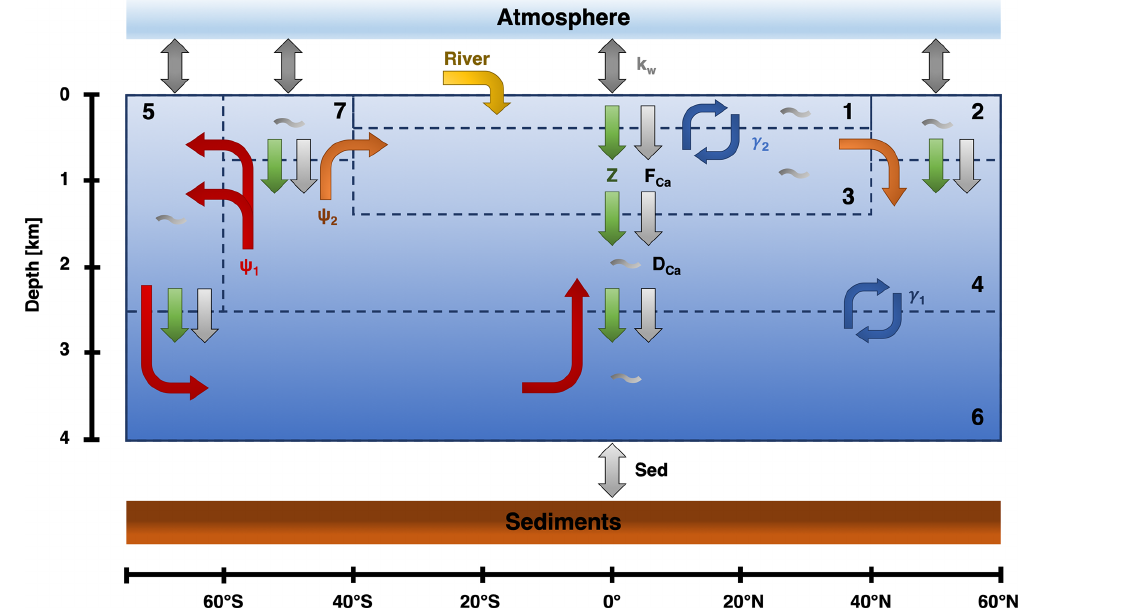
Figure 1. The box structure and fluxes for the SCP-M based on O’Neill et al. (2019). ψ 1 (red) is the GOC, ψ 2 (orange) is the AMOC, and γ 1 and γ 2 (blue) represent bidirectional mixing. Biological fluxes are represented by the green arrows, calcifier fluxes by the light gray arrows, and general dissolution of calcium carbonate by the gray wiggles in the boxes. k w (gray) represents the gas exchange between the ocean and the atmosphere. Lastly, there is an influx in box 1 via the rivers (yellow) and an outflux to the sediments (light